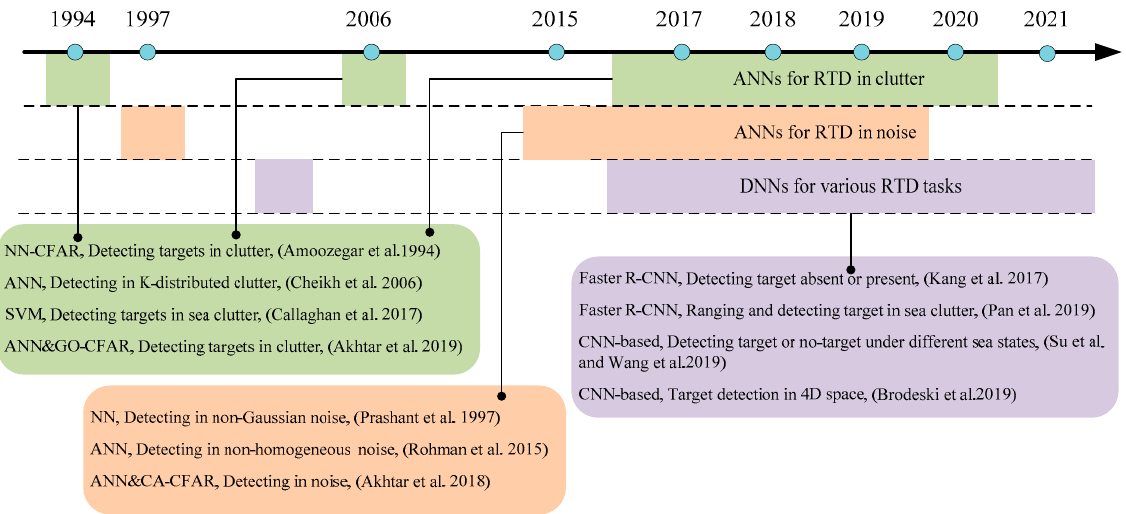
Figure 2. Major milestone of deep learning in RTD.